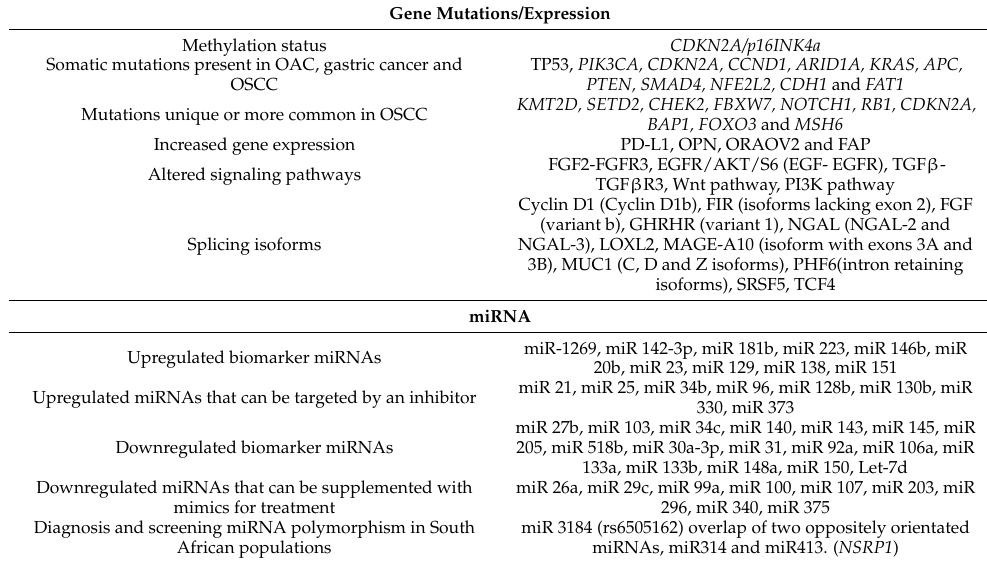
Table 5. Viable genes, pathways, isoforms and miRNAs that can be targeted for the development of clinically useful biomarkers, or could be used as lead targets for new